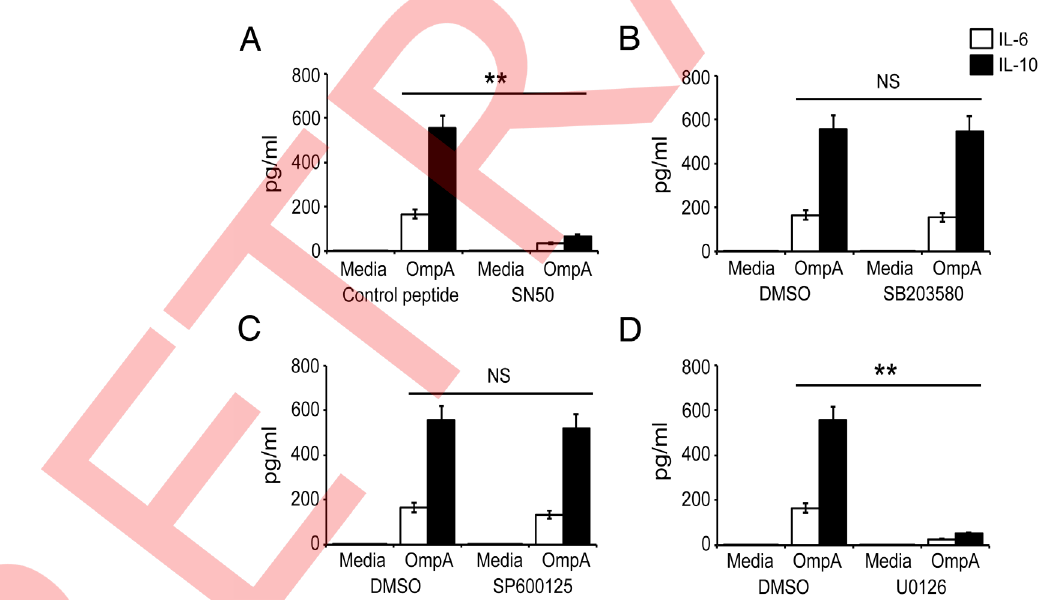
Figure 6. Effect of NF- k B-, p38-, JNK- and ERK-specific inhibitors on OmpA-stimulated production of IL-6 and IL-10. ( A-D ) B cells were purified from spleen, cultured for 1 h with vehicle or the inhibitors of NF- k B (SN50; 100 m g/ml), A , p38 (SB203580; 5 m M), B , JNK (SP600125; 5 m M), C , MEK1/2 (U0126; 5 m M) D , followed by incubation with OmpA (5 m g/ml). After 72 h of culture, the IL-6 and IL-10 levels in the cell supernatants were determined via sandwich ELISA. The data are the mean 6 S.E.M of three independent experiments. **, p , 0.01, relative to OmpA treated group in the absence of the inhibitor.